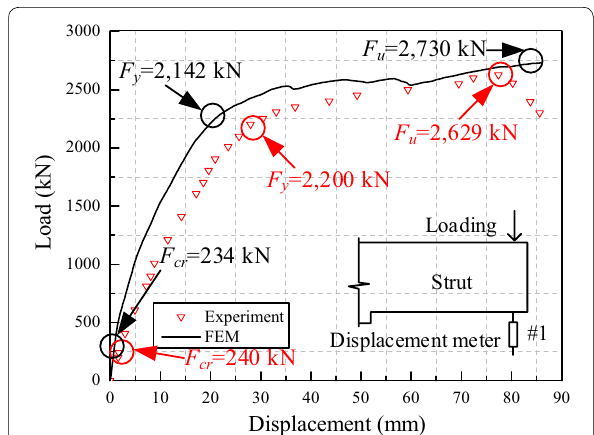
Fig. 20 Comparison of the load–displacement curves.